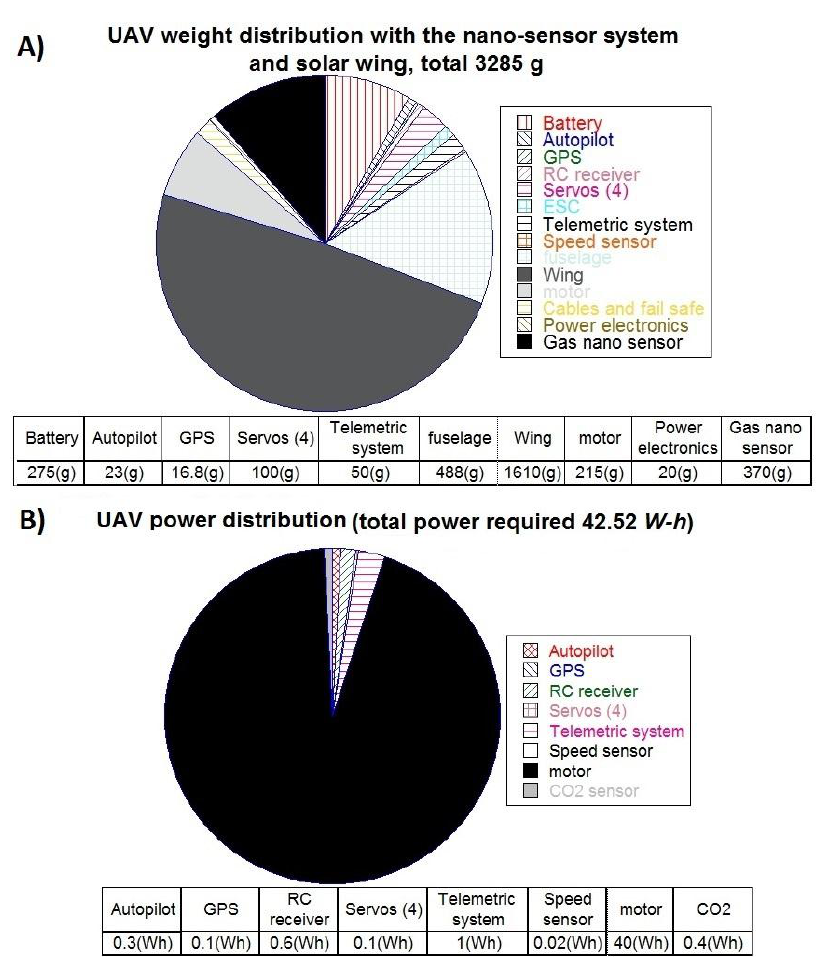
Figure 11. ( A ) Weight distribution of the UAV with the nano-sensor system; ( B ) power consumption breakdown of the UAV assembled with the CO 2 sensing